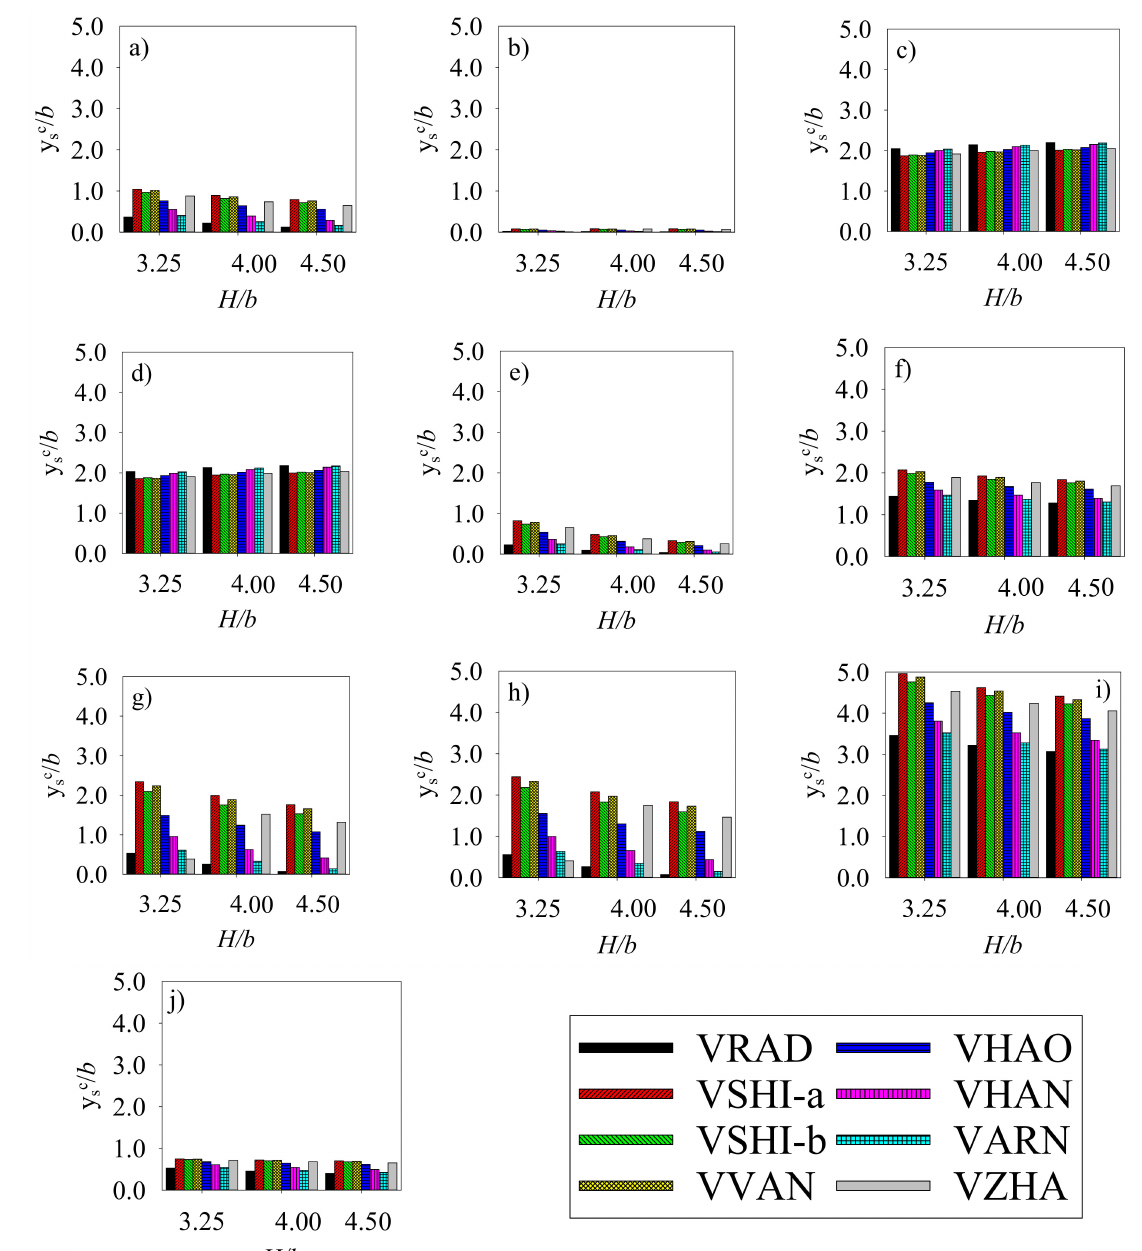
Figure 1. Variations of the nondimensional predicted scour depths, y sc / b , against the nondimensional flow depths, H / b , for different scour prediction relationships: ( a ) YHAN, ( b ) YBRE, ( c ) YJAF, ( d ) YJAI, ( e ) YKHA, ( f ) YMAS, ( g ) YGAO, ( h ) YSGAO, ( i ) YMEL, ( j )